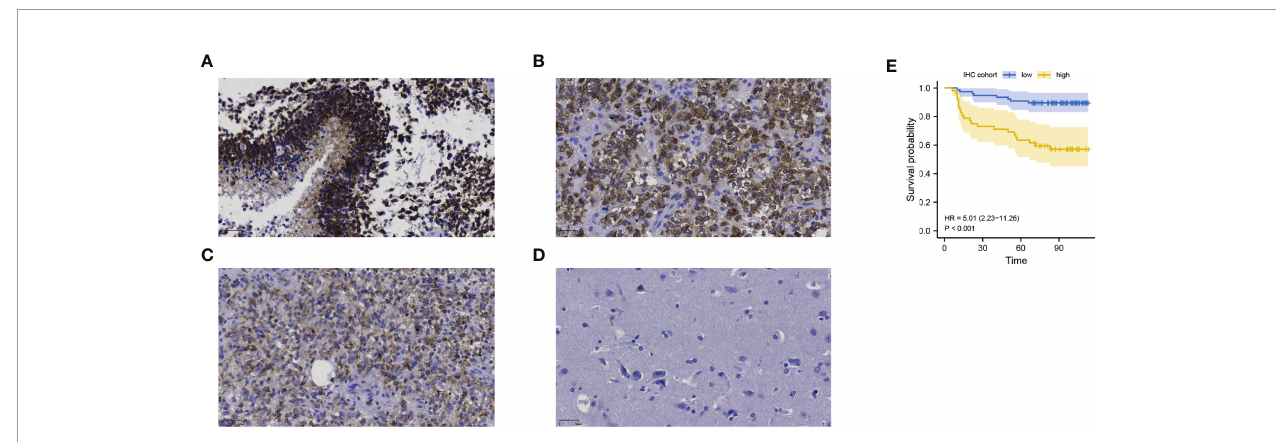
FIGURE 5 | The expression of DDOST in gliomas and its prognostic signi fi cance were analyzed by immunohistochemistry. (A – C) showed that DDOST is strongly, moderately, and weakly positive in gliomas, respectively. (D) shows the expression of DDOST in normal brain tissue. High DDOST expression in glioma was related to poor OS (E)